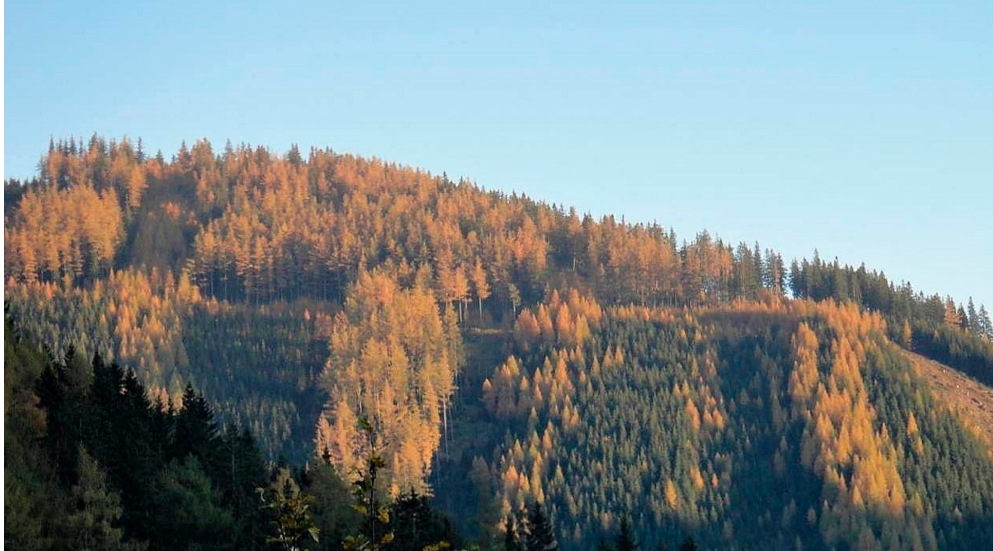
Figure 1. Example of an experimental stand under strip clear cutting management (Photo: Dirnberger). At four locations, we established three plots: one of each forest type (inner, outer, and transitional strip). All plots were on steep Northwest-oriented slopes at altitudes between 900 and 1300 m asl The plot size was between 150 and 1600 m 2 and was chosen in such a way that each plot